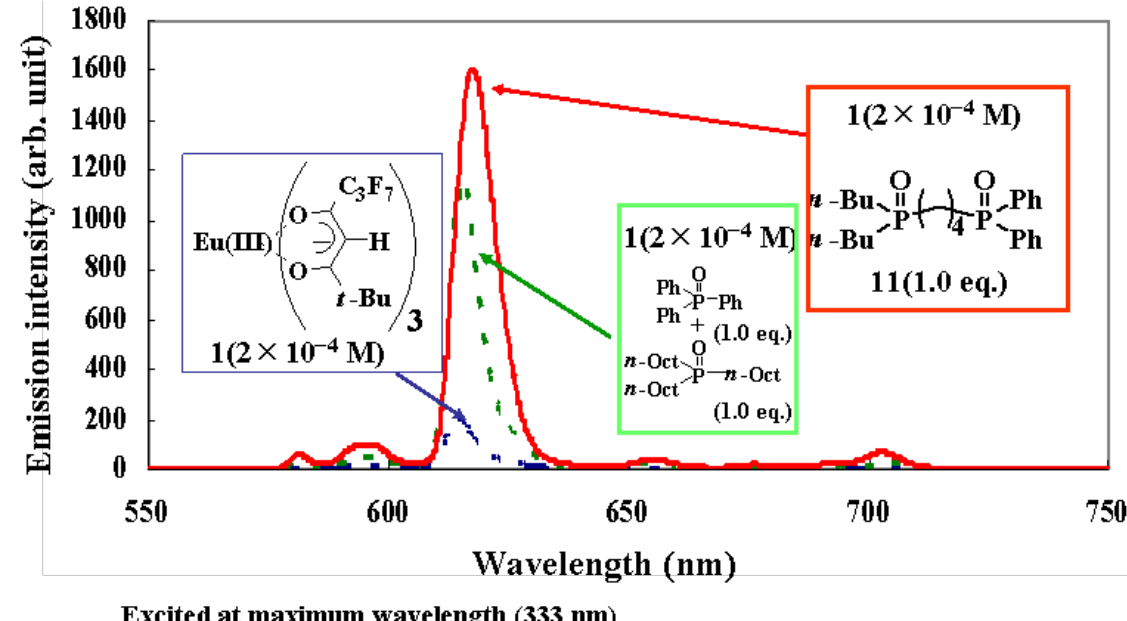
Figure 9. Emission spectra of the mixtures of Eu(III) complex 1 and phosphine oxides in the fluorinated solvent (2, 3-dihydrodecafluoropentane).